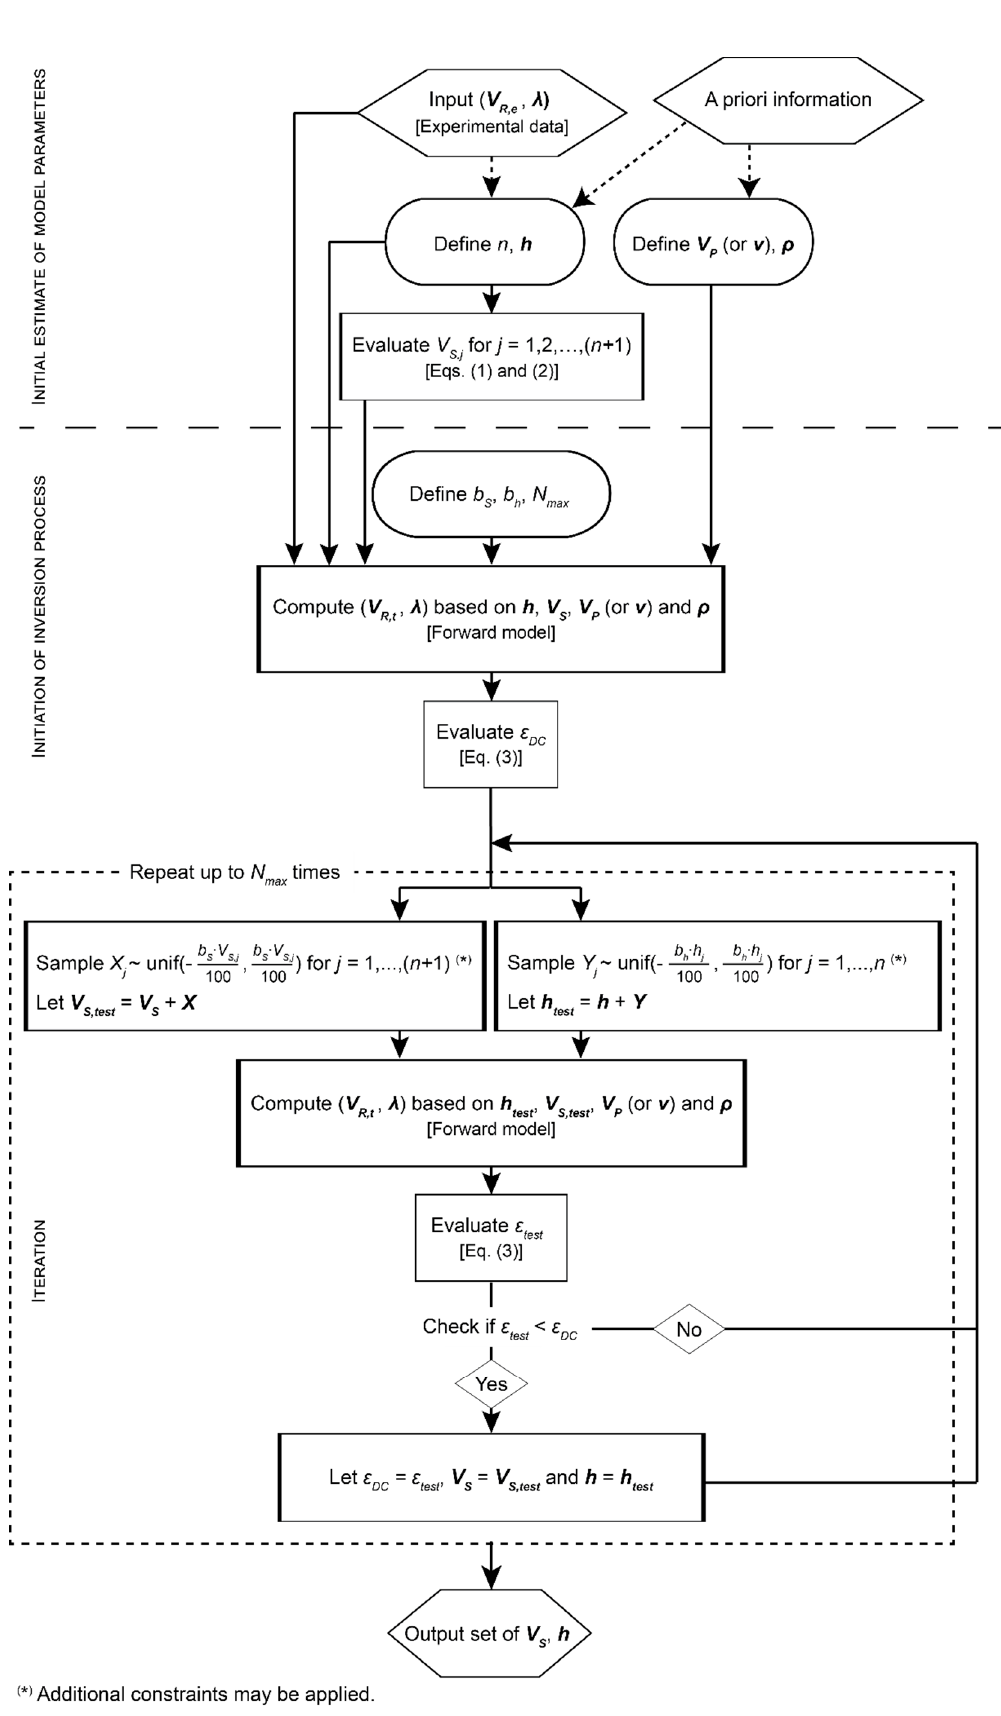
Figure 2. A schematic overview of the proposed inversion strategy.